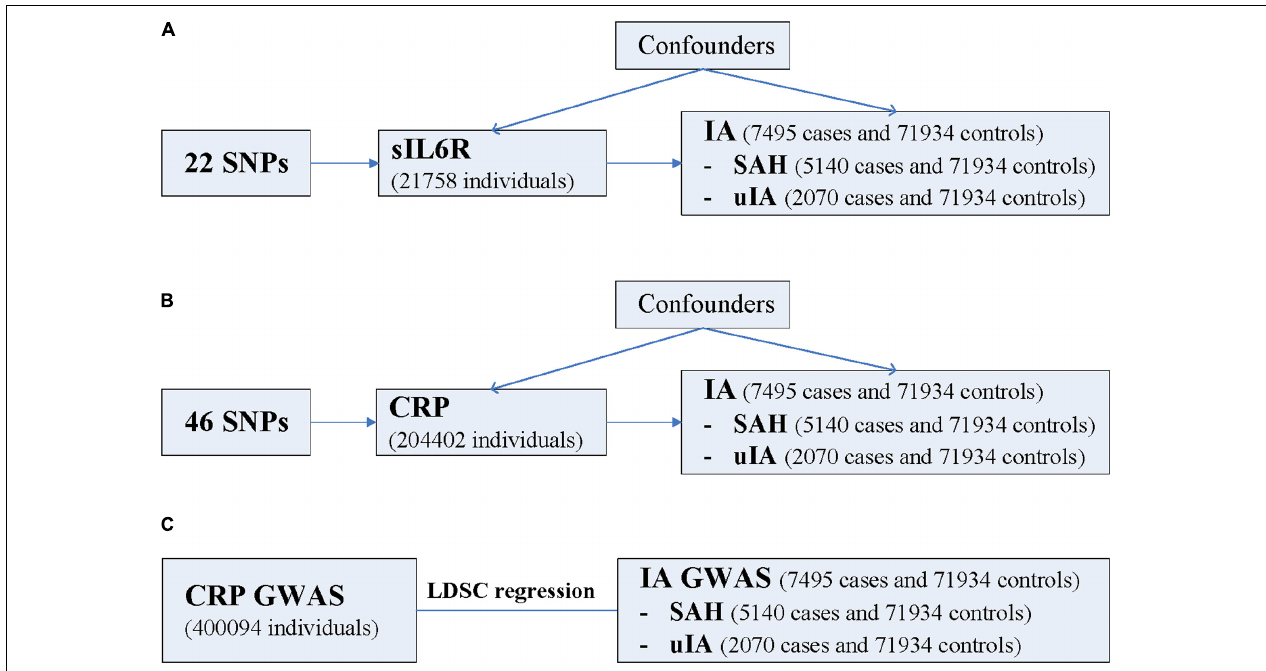
FIGURE 1 | Schematic diagram of the present study. (A) MR study of sIL6R levels on risk of IA. (B) MR study of CRP levels on risk of IA. (C) LDSC regression analysis. CRP, C-reactive protein; GWAS, genome-wide association study; IA, intracranial aneurysm; LDSC, linkage disequilibrium score; MR, Mendelian randomization; SAH, subarachnoid hemorrhage; sIL6R, soluble interleukin-6 receptor; SNP, single nucleotide polymorphism; uIA, unruptured intracranial aneurysm. The three assumptions of the two-sample MR study are as follows: instrument SNPs are associated with exposure; instrument SNPs do not affect the outcome through pathways other than the exposure; and instrument SNPs do not associate with measured or unmeasured confounders. SNPs that meet these three assumptions are considered valid instrument SNPs. Note LDSC regression analysis was not performed for sIL6R because the values of the heritability z -score and the mean Chi-square value were too